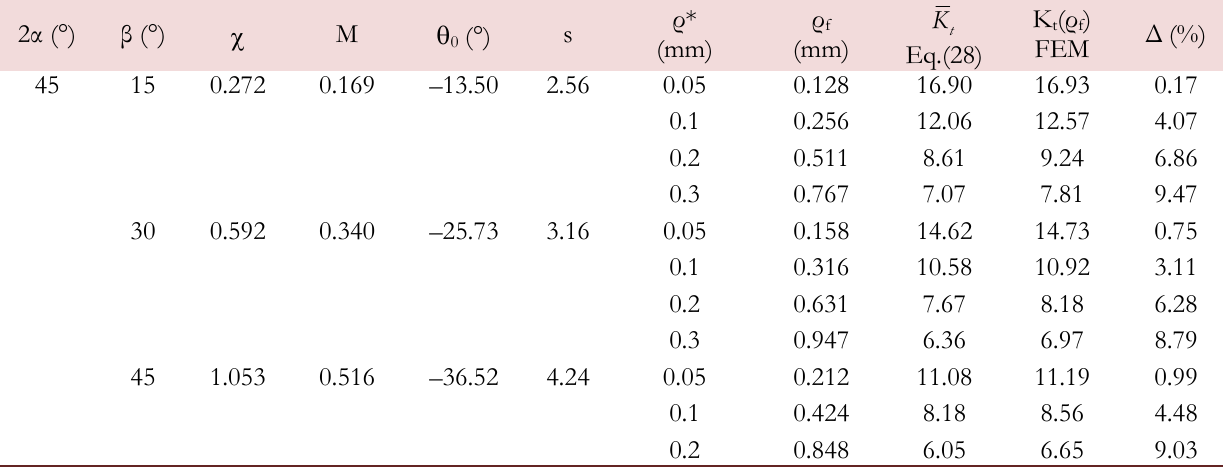
Table 2: FNR results for mixed mode loading conditions; normal stress failure criterion combined with the MTS criterion for  0 ; different values of the microstructural support length  * and the mode ratio